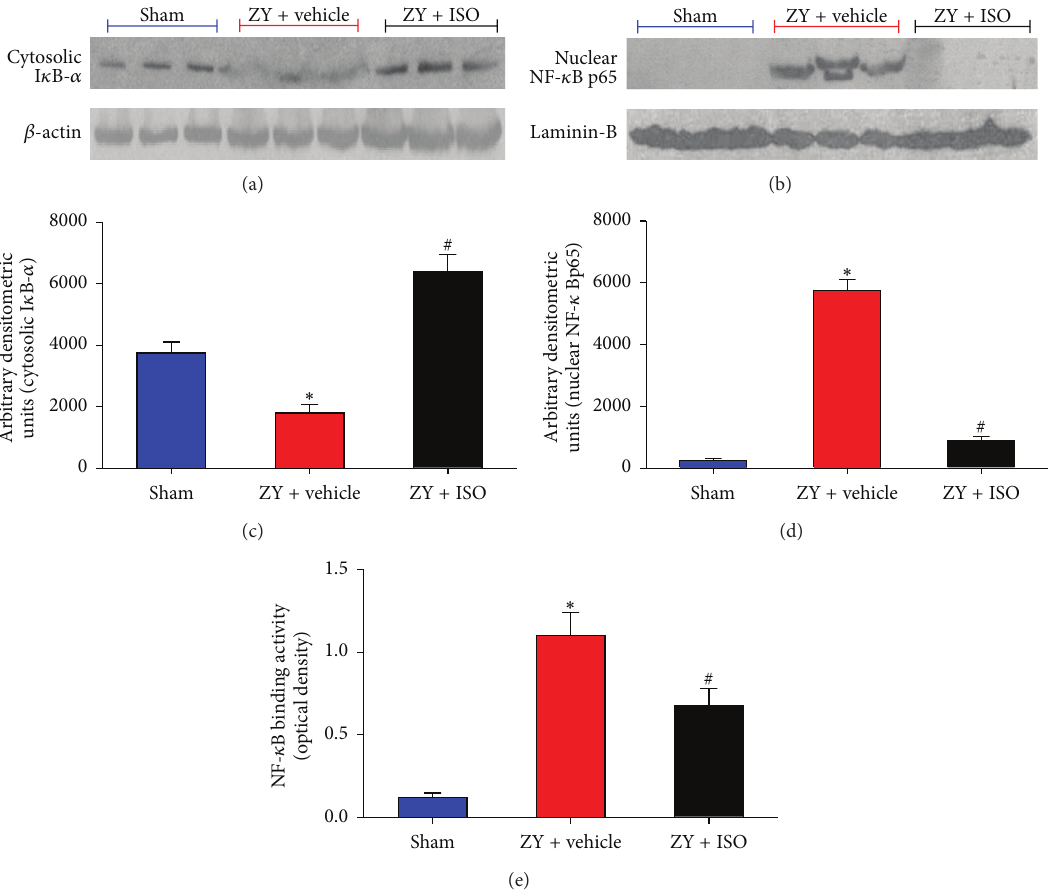
Figure 4: NF- 𝜅 B activation caused by ZY in lung at 24 hrs was reduced by 0.7% ISO treatment. Representative western blot for cytoplasmic I 𝜅 B degradation (a) and nuclear translocation of NF- 𝜅 B p65 (b). Results were quantified as arbitrary densitometry units ((c) and (d)). (e) NF- 𝜅 B DNA-binding activity as assayed by optical density. The animals were treated as shown in Figure 1(a). Data represent means ± SD ( 𝑛 = 10 mice per group). ∗ 𝑃 < 0.05 versus sham + vehicle; # 𝑃 < 0.05 versus ZY +